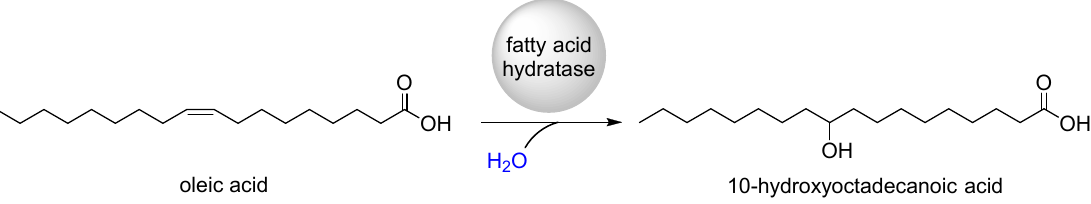
Figure 1. Reaction scheme for the synthesis of 10-hydroxyoctadecanoic acid starting from oleic acid as a selected example for the synthesis of hydrated fatty acids [37].